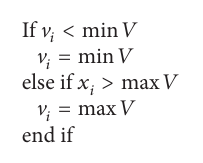
Algorithm 2: Particle velocity